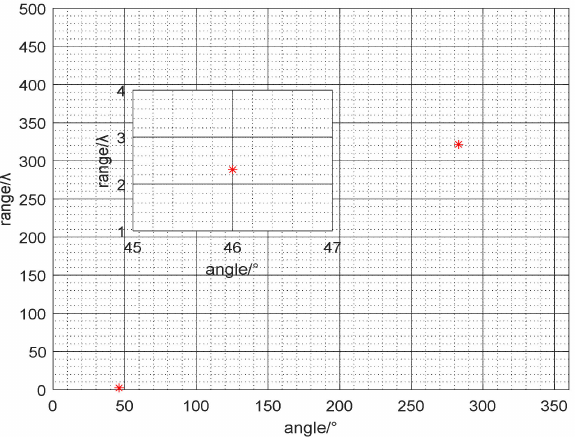
Figure 10. The azimuth map of mixed sources (Red asterisk represents the location of the